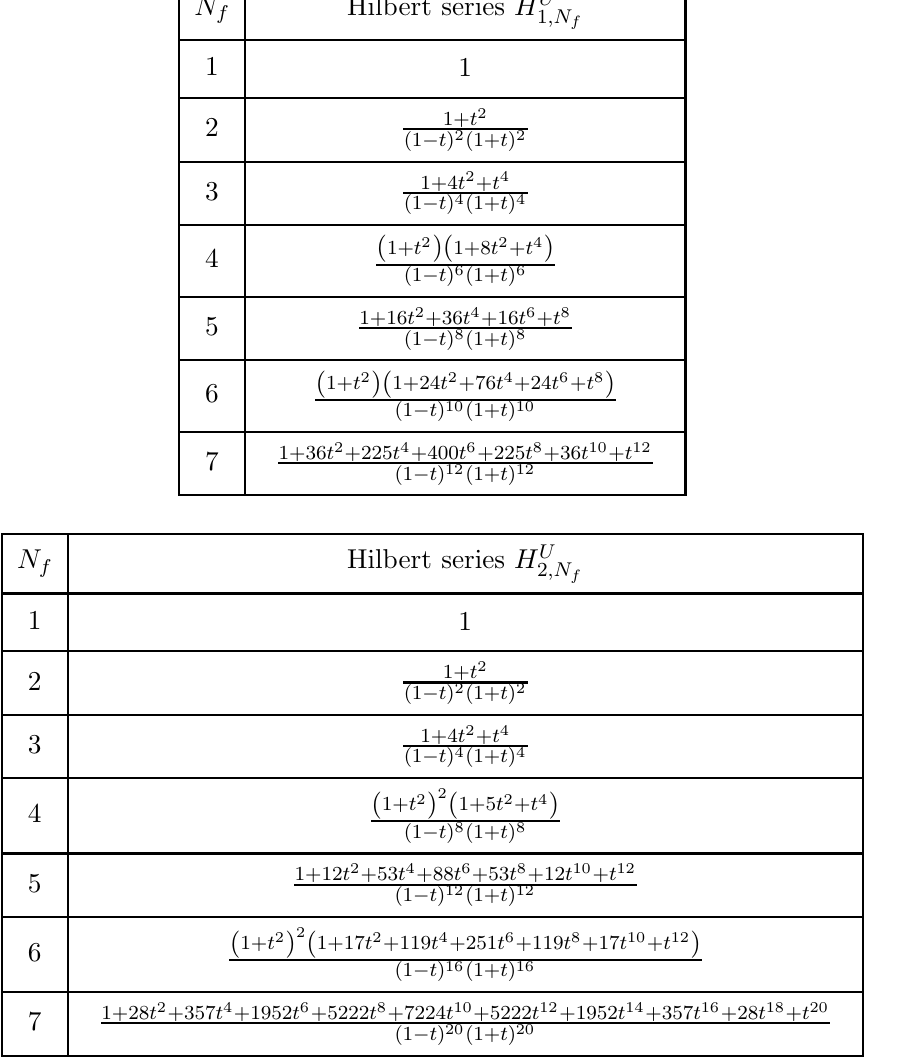
Table 2 . Hilbert series for the U(1) and U(2) theories with n